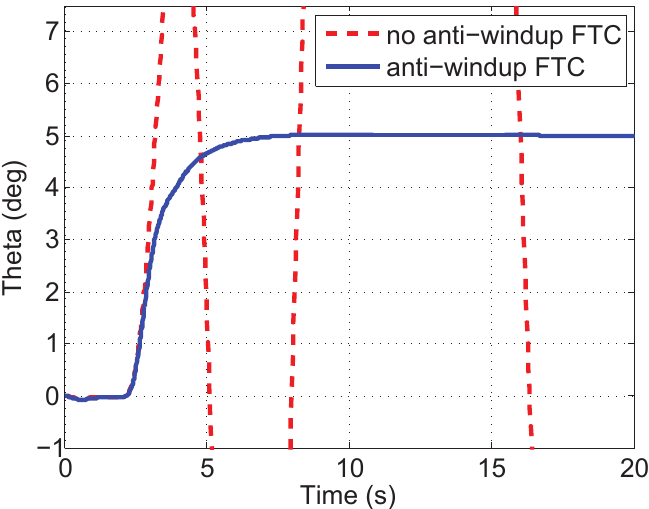
Figure 9. Effect of the integrated fault-tolerant strategy.